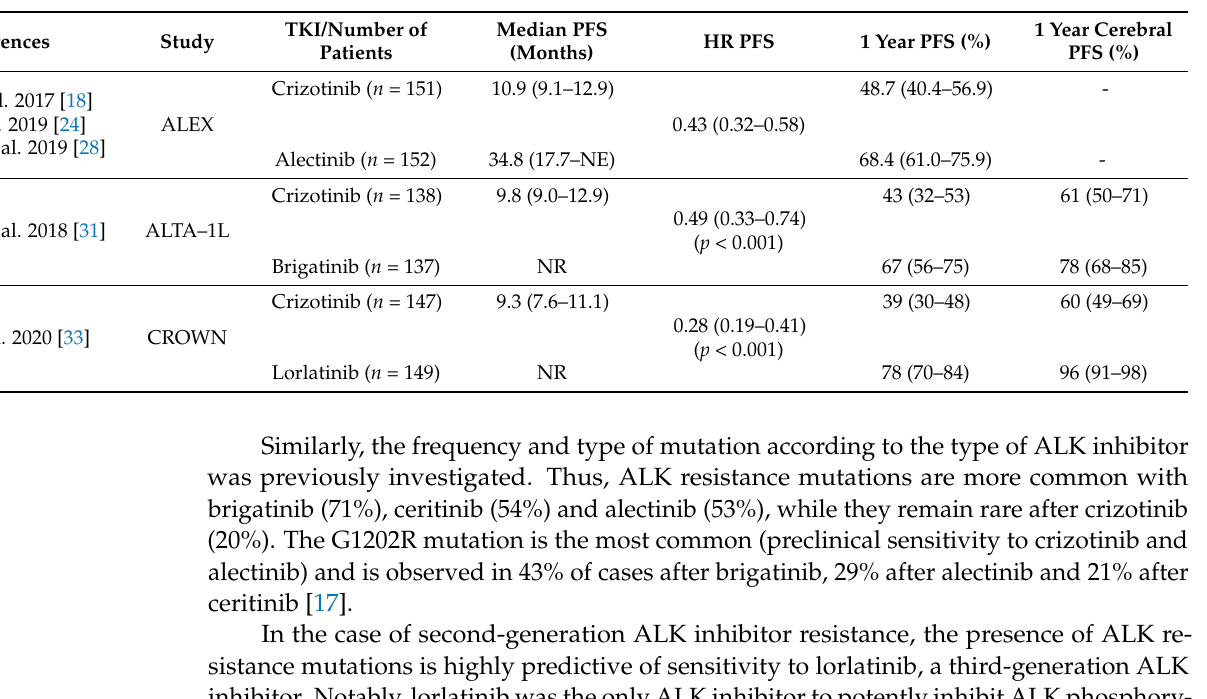
Table 1. Randomized studies evaluating first-generation tyrosine kinase inhibitors compared to second- or third-generation tyrosine kinase inhibitors in first-line treatment of metastatic non-small cell lung cancer with ALK rearrangement. TKI: tyrosine kinase inhibitor, PFS: progression-free survival, NE: not estimable, NR: not reached, HR: hazard